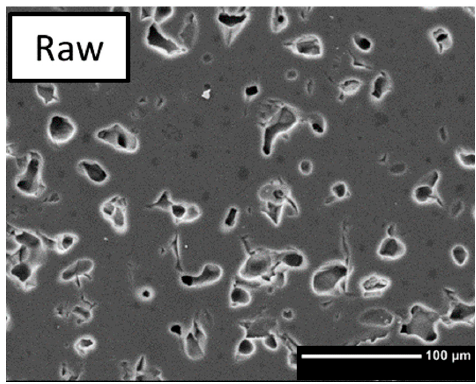
Figure 6. Sintered ß-TCP without polymer beads.